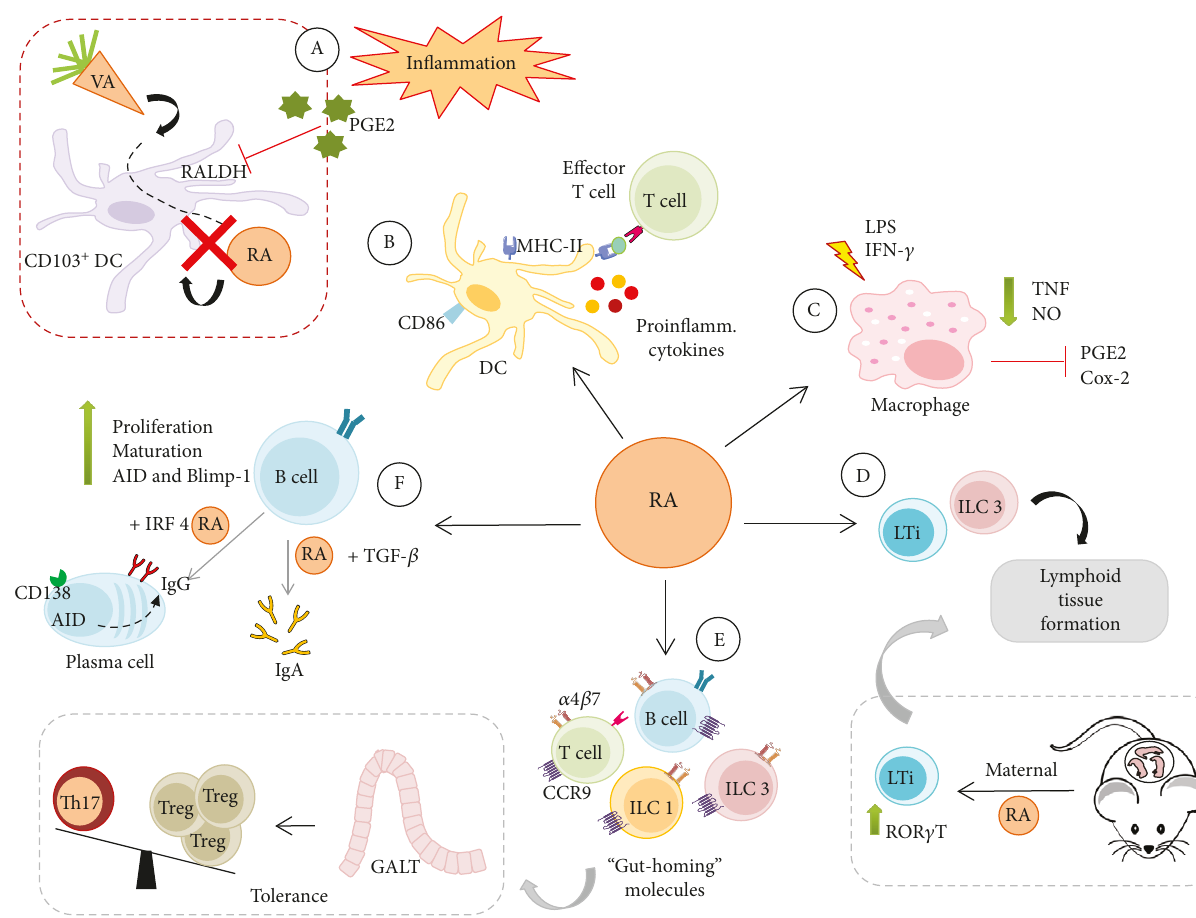
Figure 2: Role of RA in immune cells. RA can act on di ff erent cells of both the innate and adaptive immune systems exerting local action at mucosal sites and systemic action, which simultaneously, depending on where the RA-producing cells, mainly CD103 + DCs, are located when it releases the RA. (A) However, in an in fl ammatory environment (red box), PGE2 released during the in fl ammatory response inhibits the RALDH enzyme that is required for RA synthesis. When RA is released, it acts as follows: (B) RA together with proin fl ammatory cytokines contributes to the activation of DCs and the generation of e ff ector T cells; (C) RA promotes macrophage modulation, inhibiting in fl ammatory mediators and the release of TNF and NO; (D) RA also activates ILC3, especially LTi cells, which are required for the formation of lymphoid tissue, including during fetal development; (E) RA induces expression of the molecules α 4 β 7 and CCR9 in lymphocytes and ILCs and the homing of these cells into the intestine and promotes the balance of Th17/Treg cells in the GALT, assuring tolerance, but is also able to induce Th17 in the presence of infection and in fl ammation; and (F) RA promotes the activation of B cells and their di ff erentiation into Ab-secreting plasma